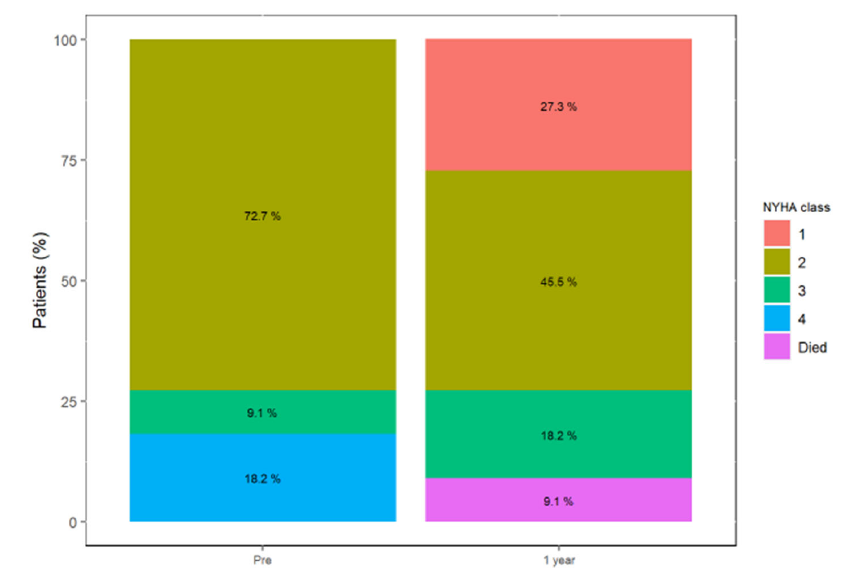
Figure 4. NYHA functional status at baseline and one year follow ‐ up.